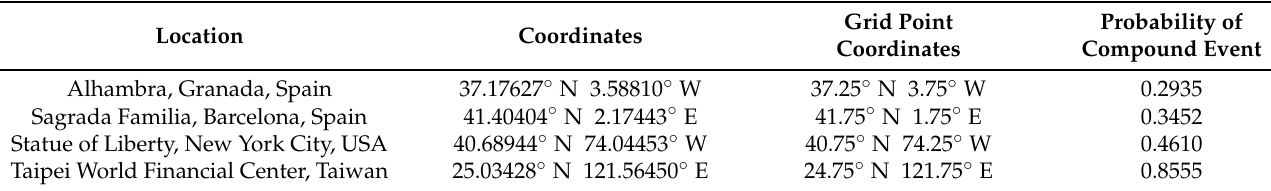
Table 1. Selected locations, their coordinates, the coordinates of the grid points chosen in our dataset and their probability of compound event (simultaneous precipitation and wind events, over the thresholds of 0.1 mm · d − 1 and 0.01 m · s − 1 , in the period